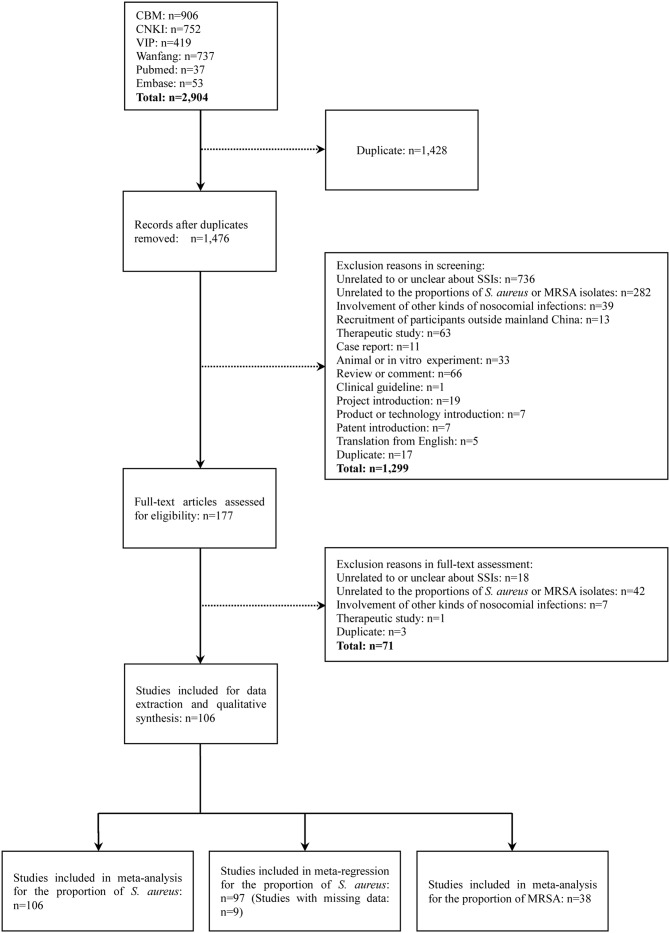
Flow diagram of study inclusion.